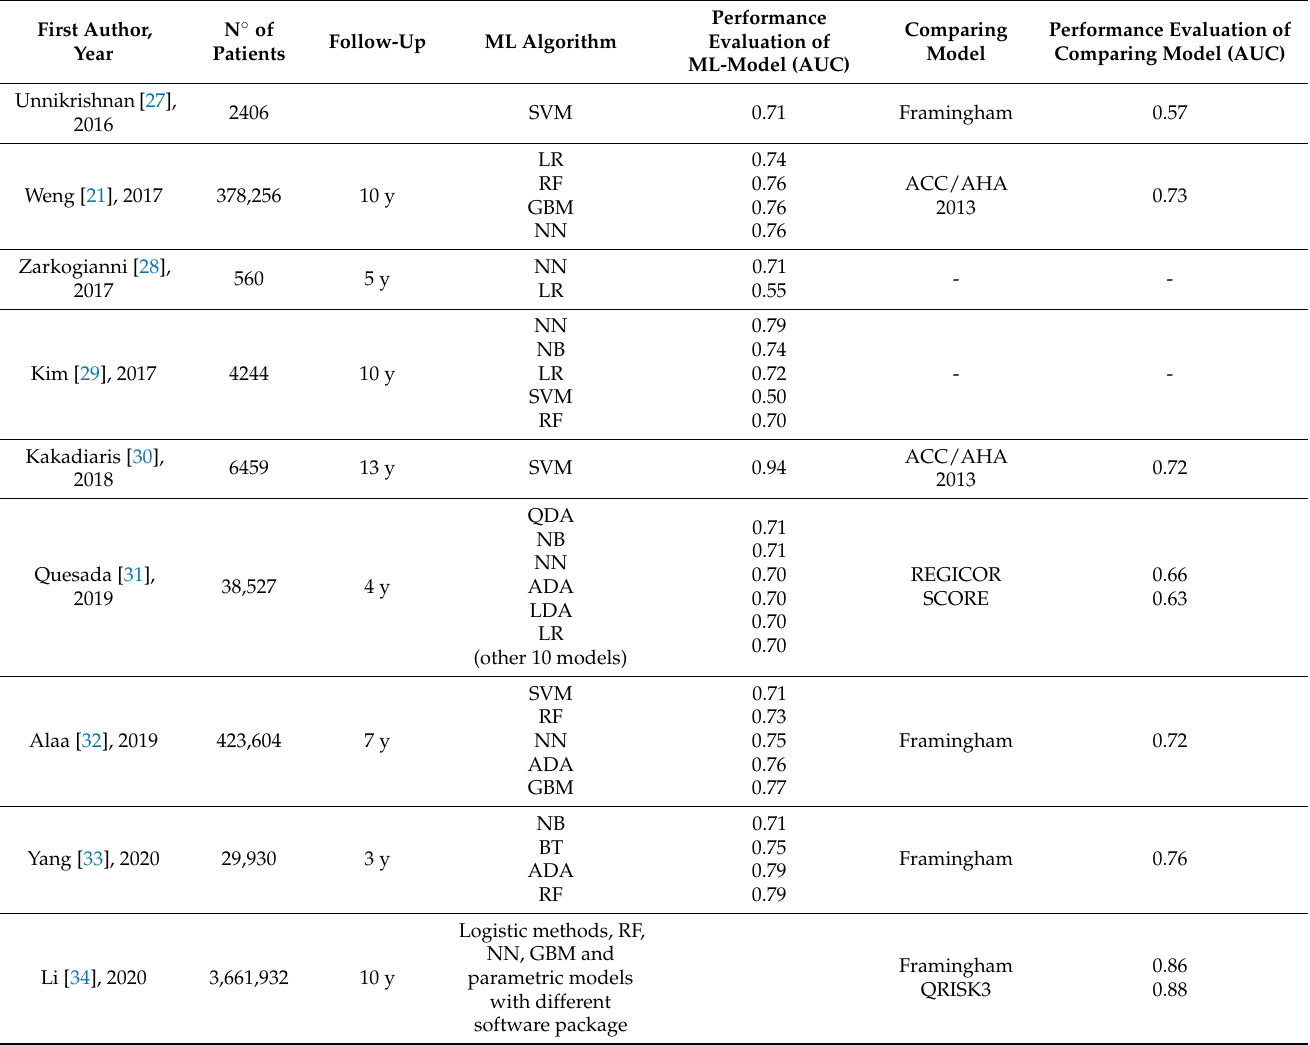
Table 1. Comparison of studies that investigated the utility of machine learning models for CVD prevention at a general population-based